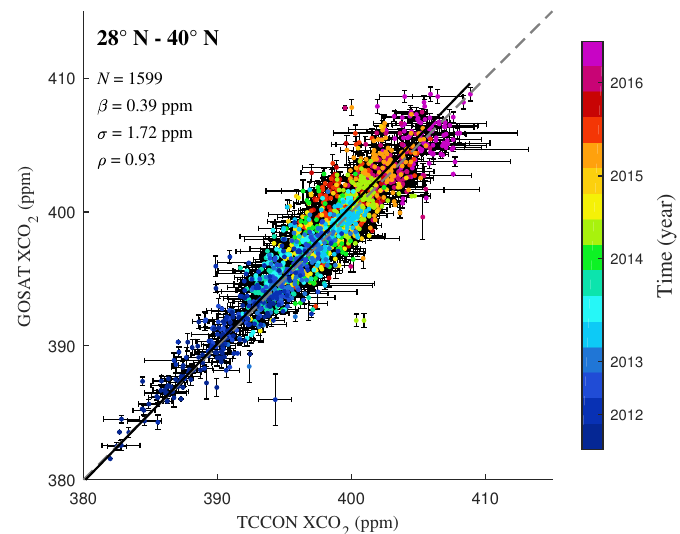
Figure 7. Scatter plot of the collocations of the TCCON and GOSAT XCO 2 over 28 ◦ N–40 ◦ N, which is similar to the second panels in Figure 5b but with the colors representing the change in time instead of the TCCON sites. The temporal range is from September 2009 to May